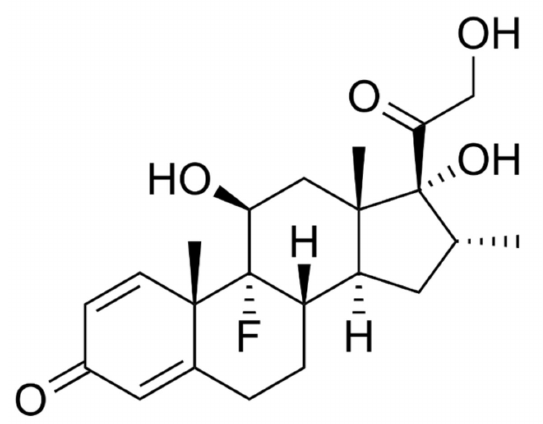
Figure 17. Structure of Dexamethasone.